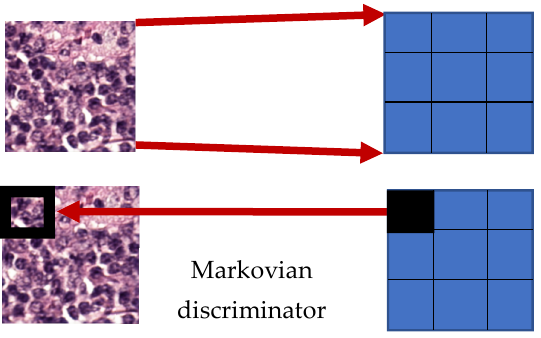
Figure 5. Markovian discriminator.